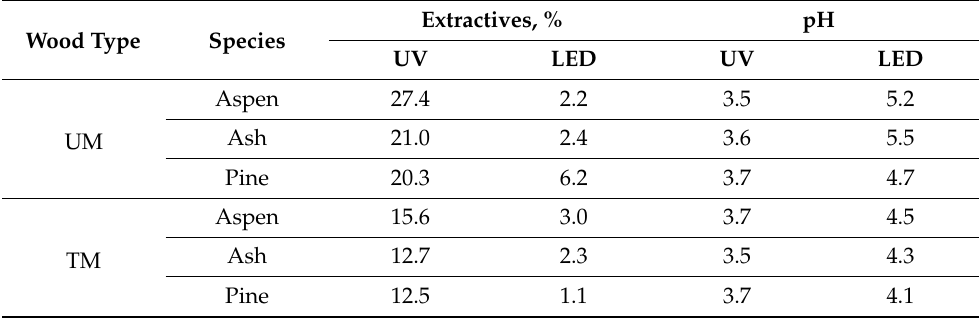
Table 1. Content of water-soluble components in unmodified (UM) and thermally modified (TM) wood formed due to exposure to UV and LED lamps and pH of